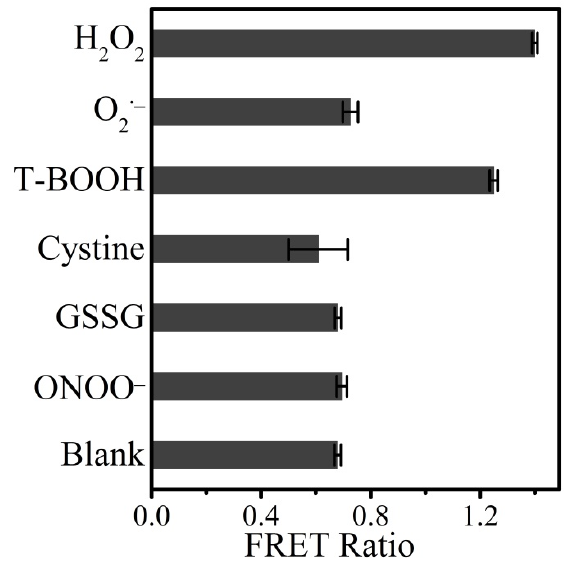
Figure 5. Interference of common oxidant on FRET signal of CPmTY. Concentration of oxidized glutathione (GSSG), cysteine, tert-butyl hydroperoxide (t-BOOH): 1 μ M, H 2 O 2 : 100 nM, superoxide radicals (O 2 − ) and peroxynitrite anion (ONOO − ) were produced in situ by specific enzymatic reactions as described in experimental section.